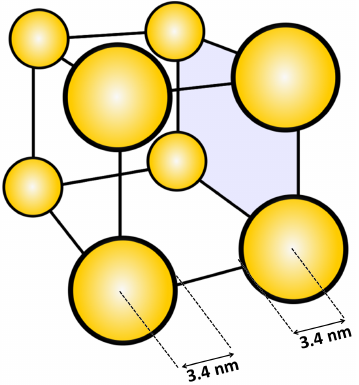
Figure 9. Distribution of the calculated number of particles for composites at pH 8 in a cube with a volume of (10 ˆ 10 ˆ 10) nm 3